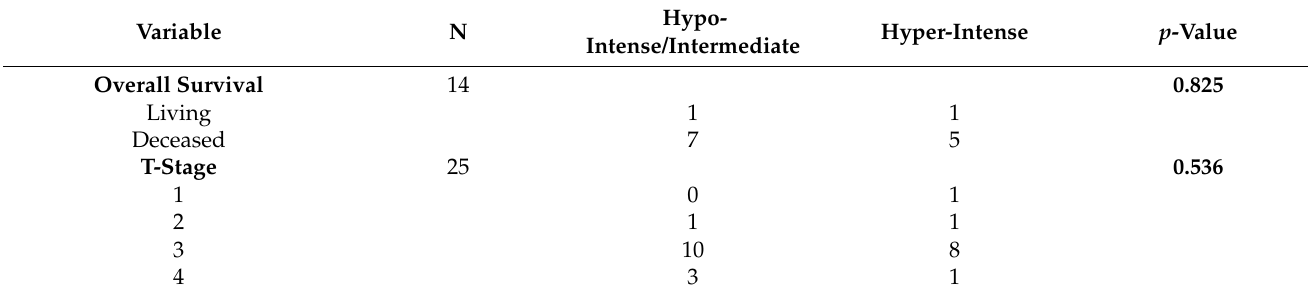
Figure 5. High JAM-A expression in full-face sections of GE cancer cases is significantly associated with HER2 positivity. Hypo-intense/intermediate or hyper-intense JAM-A expression in 25 full-face sections of primary GE tumors (moderately or poorly differentiated) was correlated with HER2 status, where HER2 was deemed positive with an IHC score ≥ 2+. Statistical analysis consisted of Fisher’s exact test using GraphPad Prism version 8.4.3 (GraphPad Software, San Diego, CA, USA); with comparisons considered significant at * p < 0.05. Table 3. Hyper-intense JAM-A expression significantly correlates with HER2 positivity in GE cancer full-face